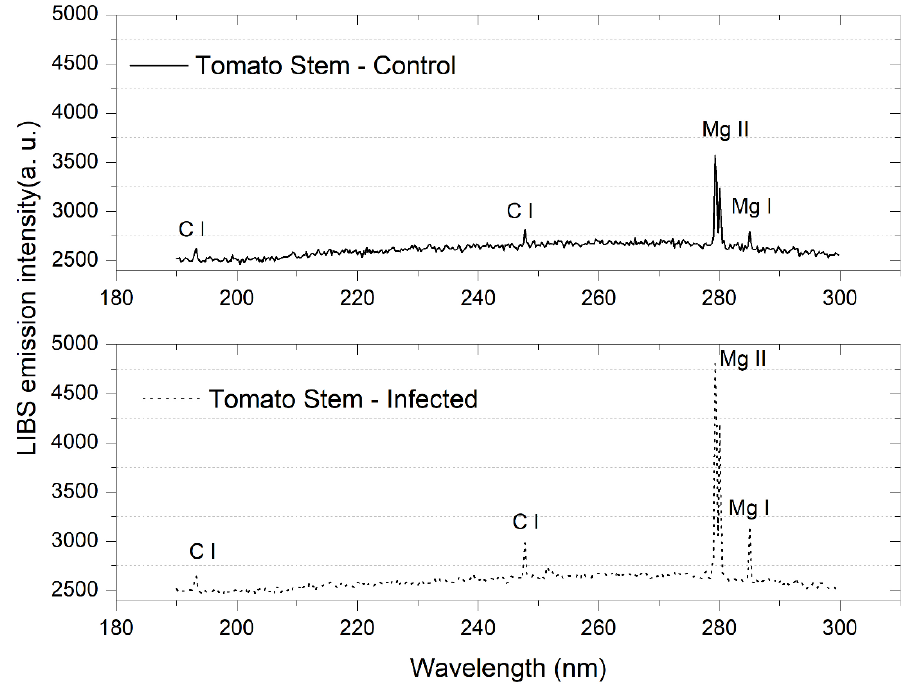
Figure 6. LIBS spectra of tomato stems of control plants and plants with roots infected by M. incognita .